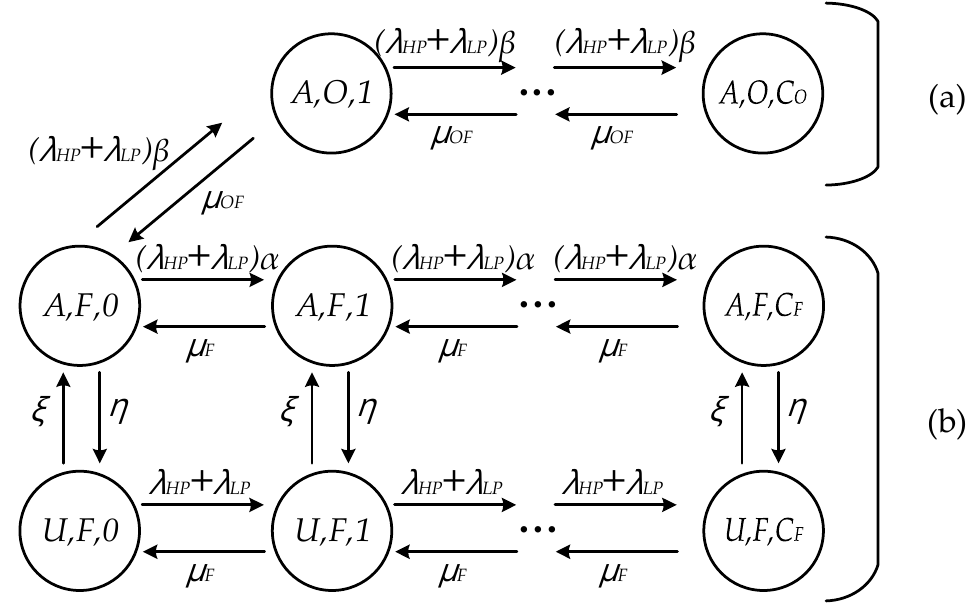
Figure 3. Markov chain model of the conventional scheme: ( a ) OFN; ( b ) FN.